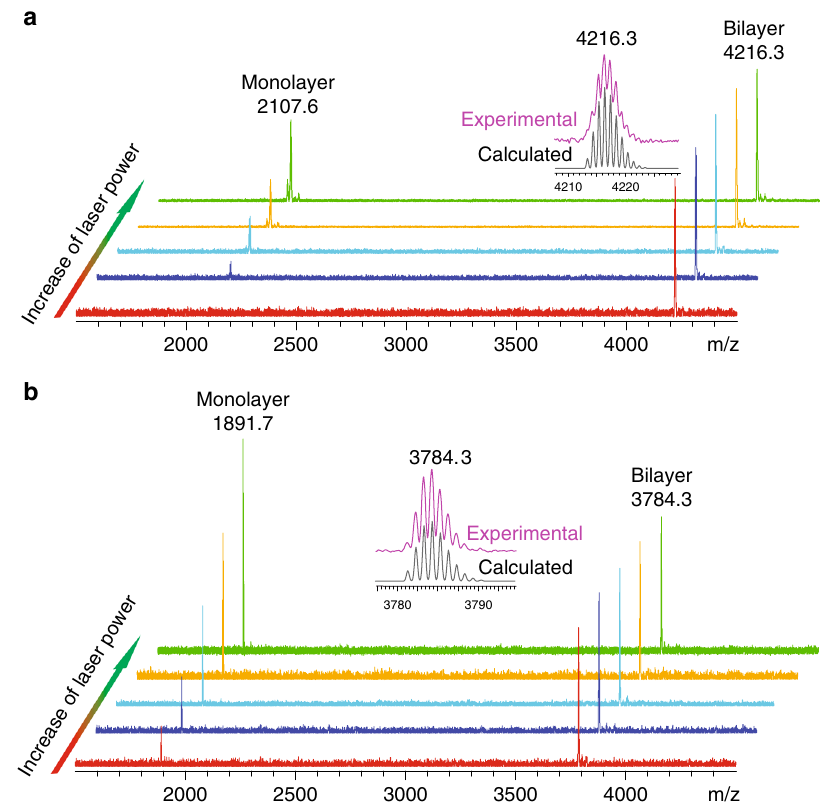
Fig. 1 Mass spectra of molecular bilayer graphenes. The mass spectra of 1 ( a ) and 2 ( b ) with different desorption laser powder. The insert fi gures represent the isotopic distribution for the mass peak of 1 and